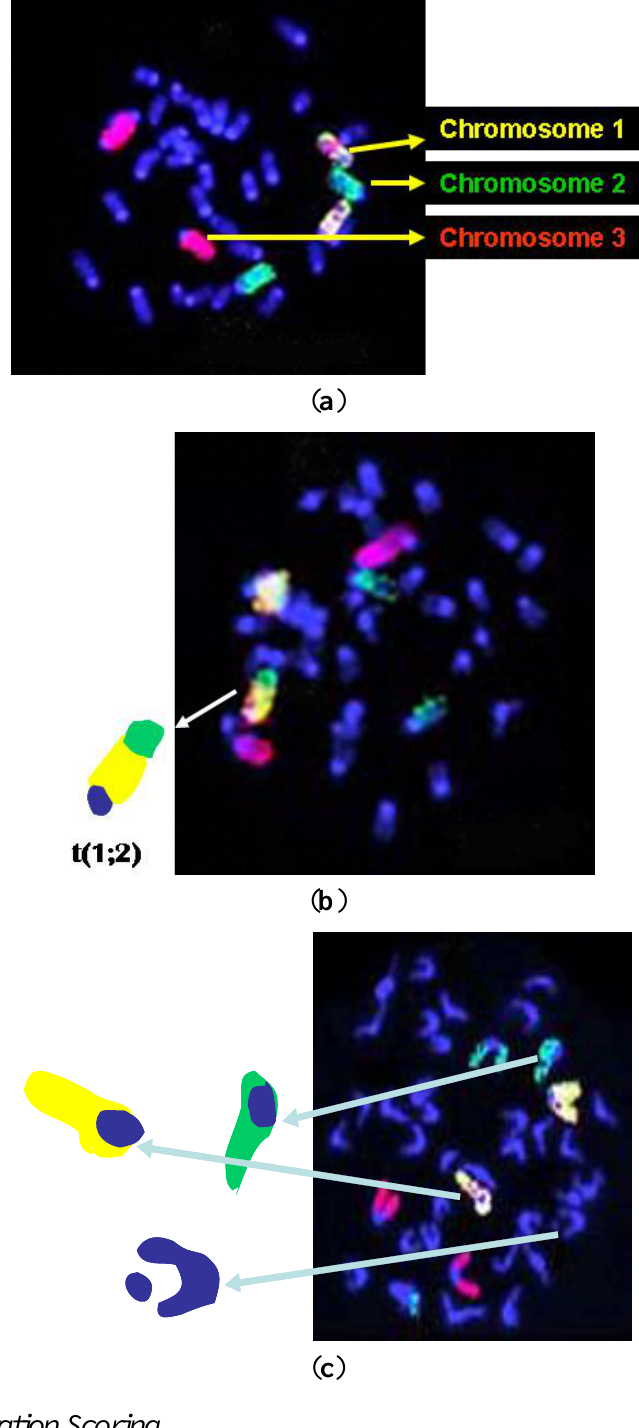
Figure 1. ( a ) Representative image of a normal metaphase cell; ( b ) Representative image of a metaphase with a translocation between mouse chromosomes 1 and 2 (arrow), and ( c ) Representative image of a metaphase with chromatid breaks on chromosomes 1, 2, and